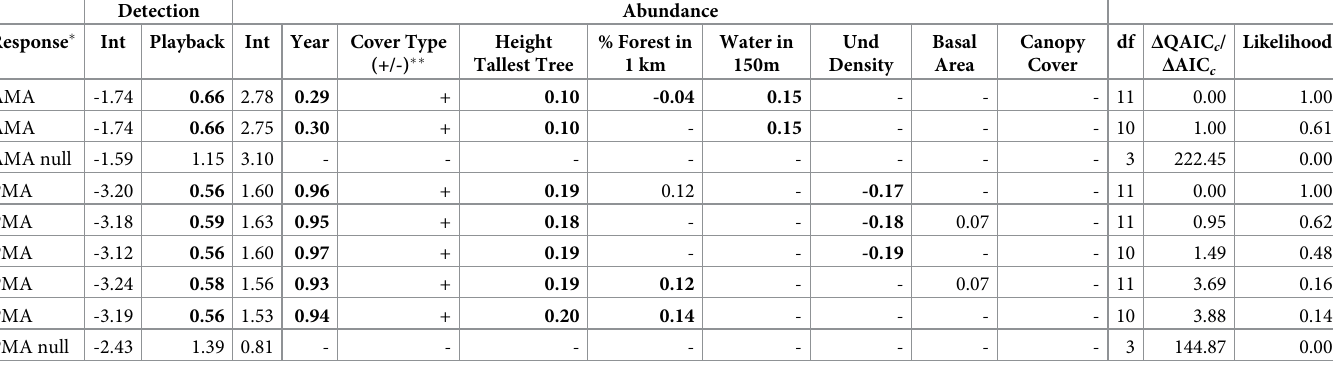
Table 1. Supported abundance models and null models for all migrants and priority migrants. Models were selected by likelihood value � 0.125 and the absence of uninformative parameters. Bolded coefficients indicate significance at P � 0.05.